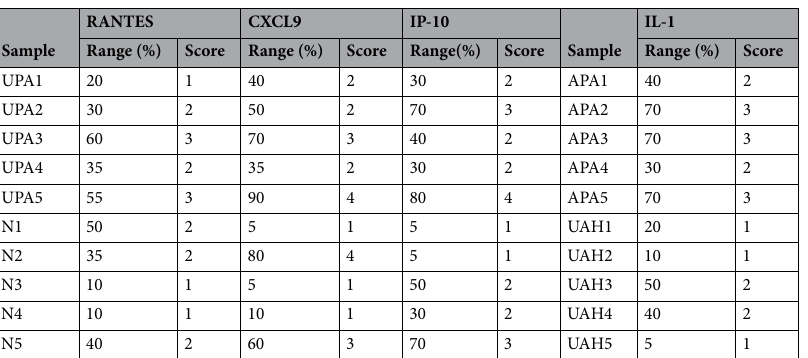
Table 5. The result of immunohistochemical staining. UPA: unilateral primary aldosteronism; N: normal adrenal gland; APA: aldosterone-producing adenoma; UAH: unilateral adrenal hyperplasia; Range: the distribution range of positive cells; Score: on a scale of 1 to 4, the distribution of positive cells ranging 0–25% rated 1, ranging 26–50% rated 2, ranging 51–75% rated 3, and ranging 76–100% rated